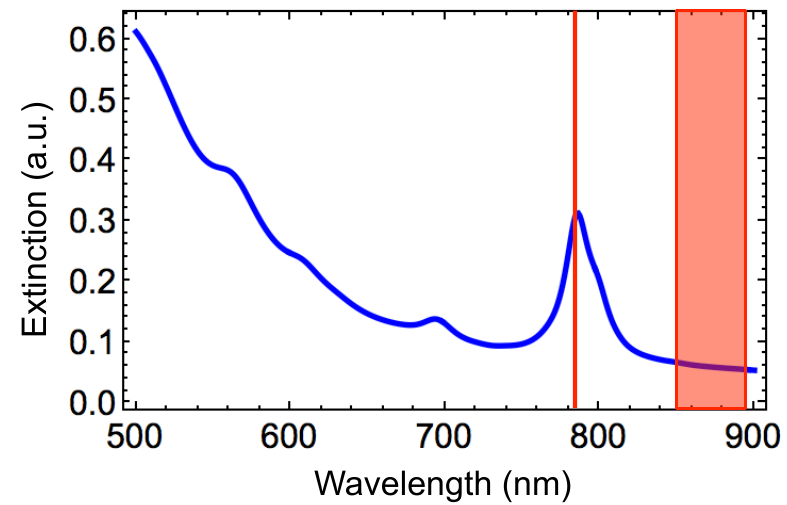
Figure 5. Calculated extinction spectrum of the hybrid Au/Si disk-shaped nanoresonators. The red line matches to the excitation wavelength of 785 nm. The full red rectangle represents all the Raman wavelengths ( λ Raman ) corresponding to the associated Raman shifts (from 1000 to 1575 cm − 1 , see Table